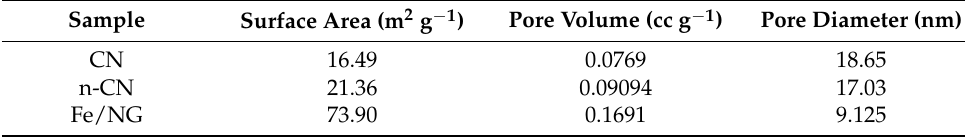
Figure 5. ( a ) Nitrogen adsorption–desorption isotherms of CN, n-CN, and Fe/NG. ( b ) Magnetic hysteresis loops of Fe/NG at 298 k. Table 1. BET analysis of synthesized